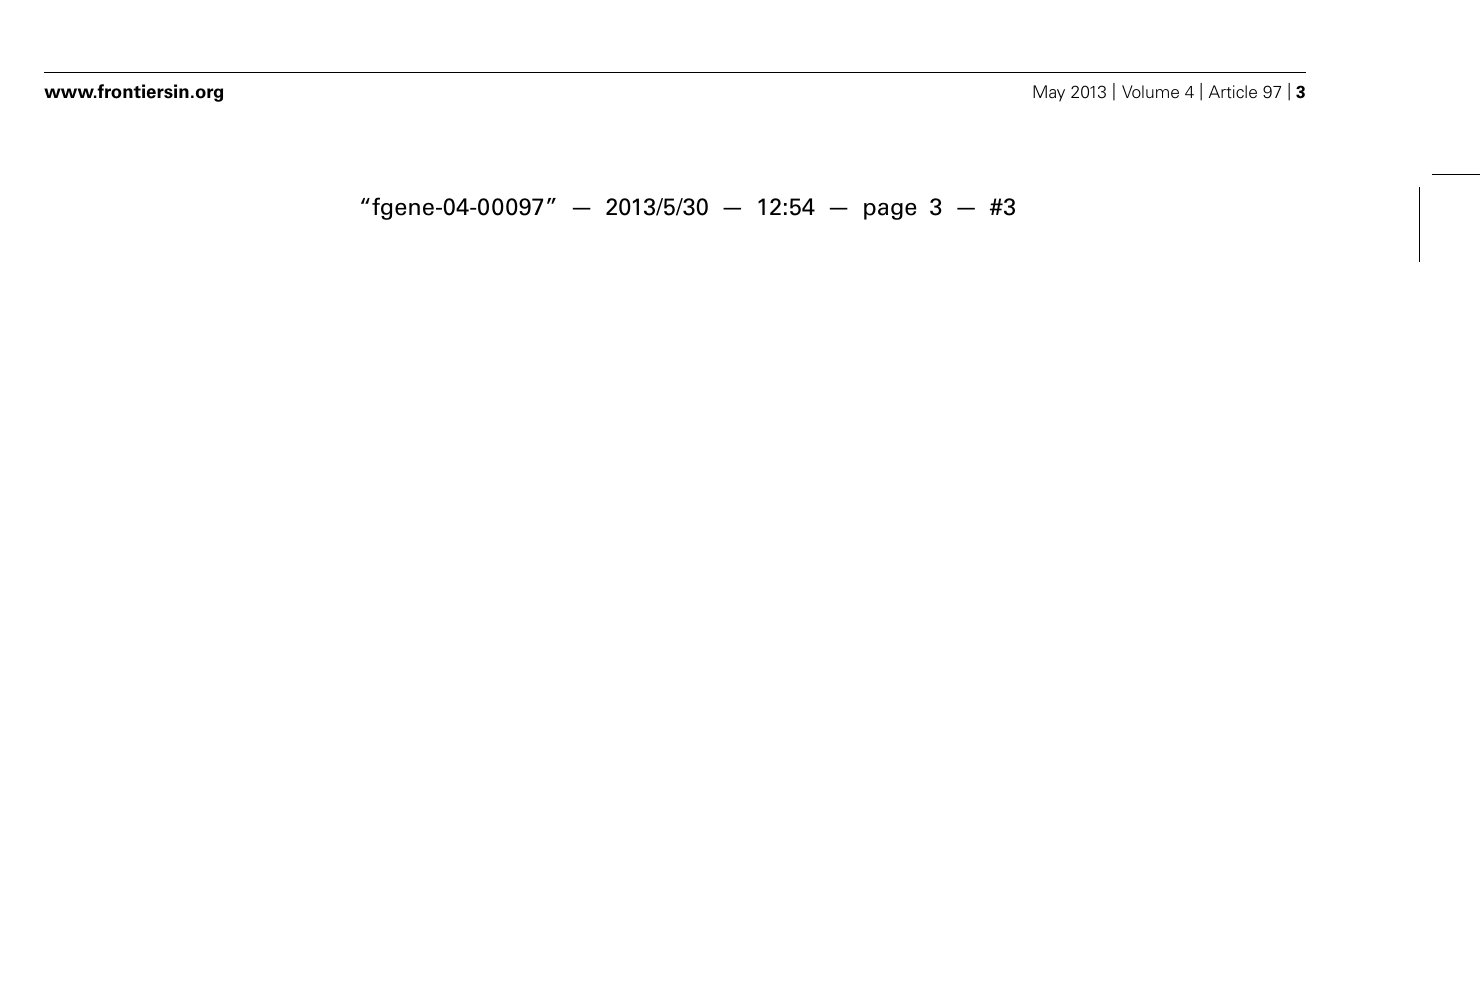
FIGURE 2 | Relationship between expression of (A) N-cadherin and E-cadherin, and (B) E-cadherin and Snail normalized to β -actin expression. The lines indicate best-fit hyperbolae.